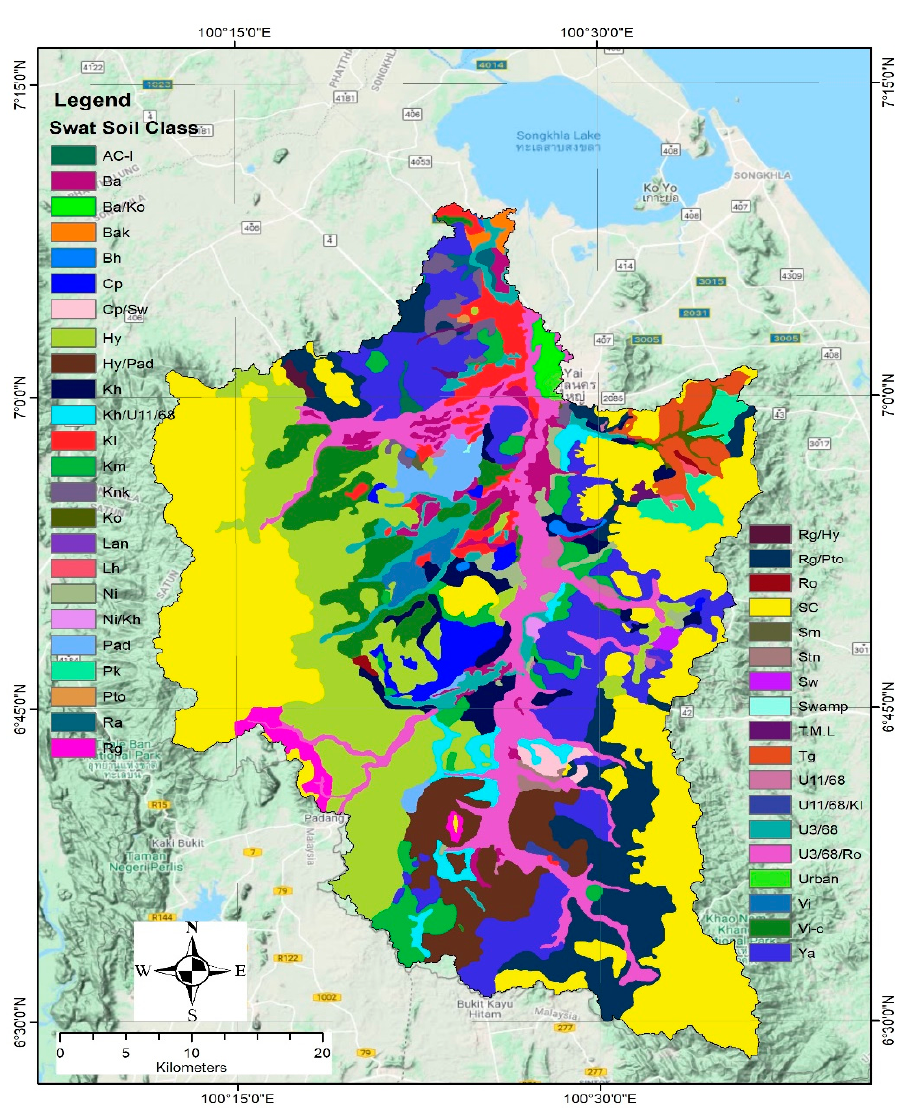
Figure 5. Soil map of the URB (use color) .